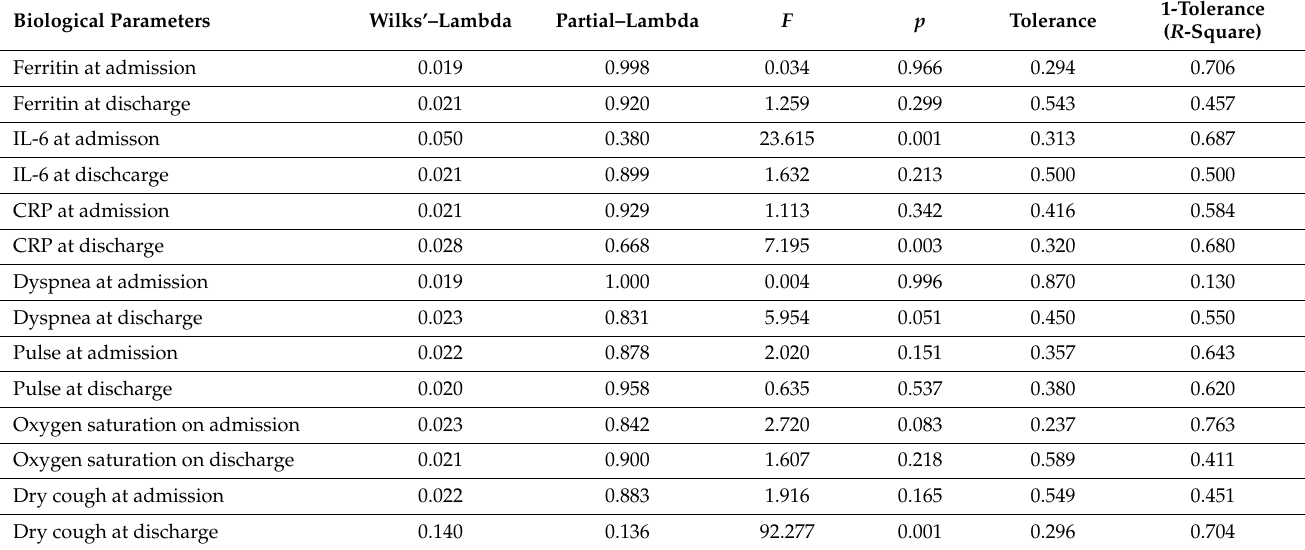
Table 3. Discriminant function analysis summary (grouping mild physiotherapy/active physiother- apy/no